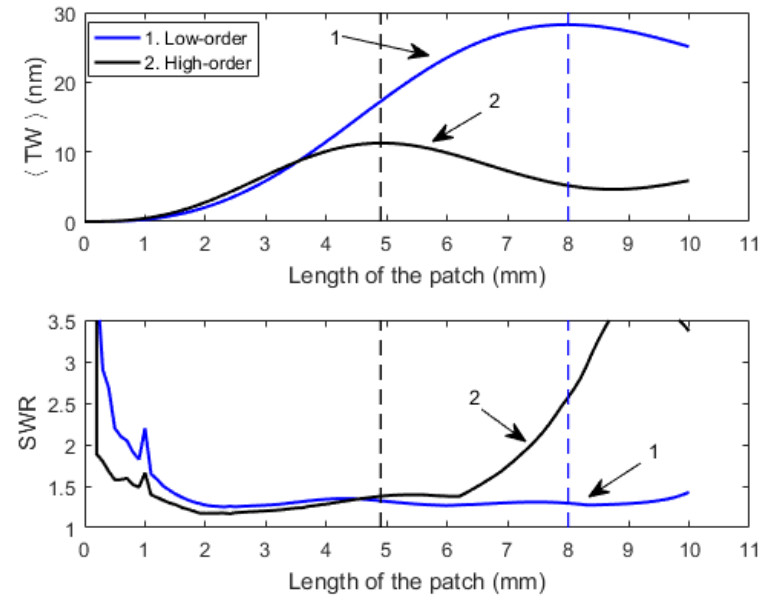
Figure 2. Average displacement of the traveling wave envelope (<TW>) and standing wave ratio (SWR) as a function of the length of the patch for both the low-order (blue) and the high-order (black) combinations.